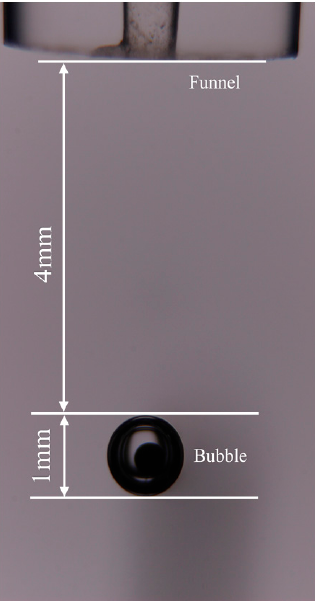
Figure 2. Diagram of relative position between feeding funnel and bubble.